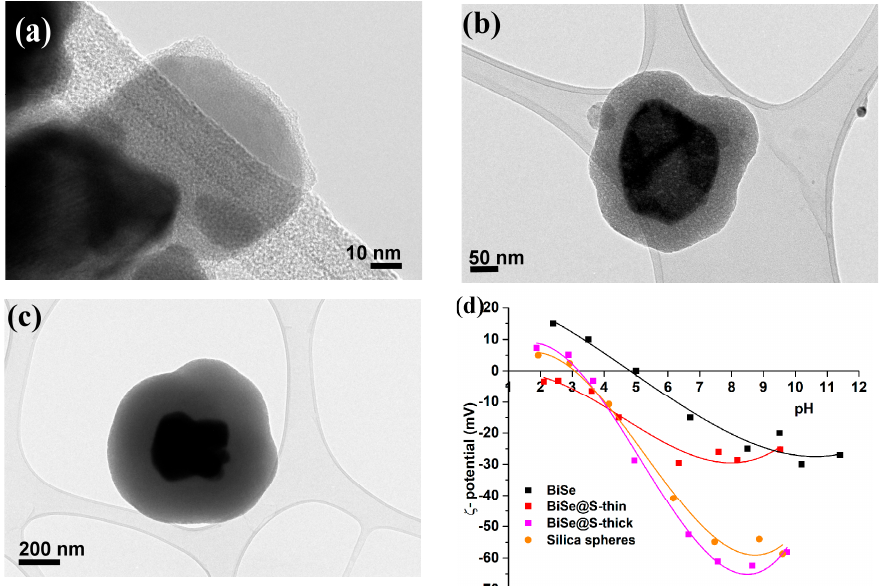
Figure 2. TEM image of silica-coated Bi 2 Se 3 nanoparticles with thin ≈ 2–5 nm ( a ), intermediate ≈ 50–80 nm ( b ) and thick ≈ 200 nm silica layer ( c ). Zeta-potential behavior of silica-coated Bi 2 Se 3 nanoparticles compared to uncoated nanoparticles and silica nanospheres ( d ).